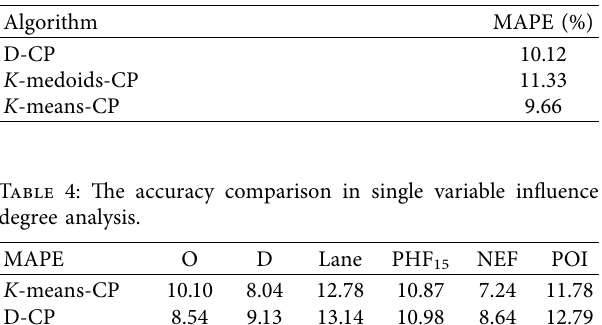
Table 3: The accuracy comparison of joint influence degree of variables.